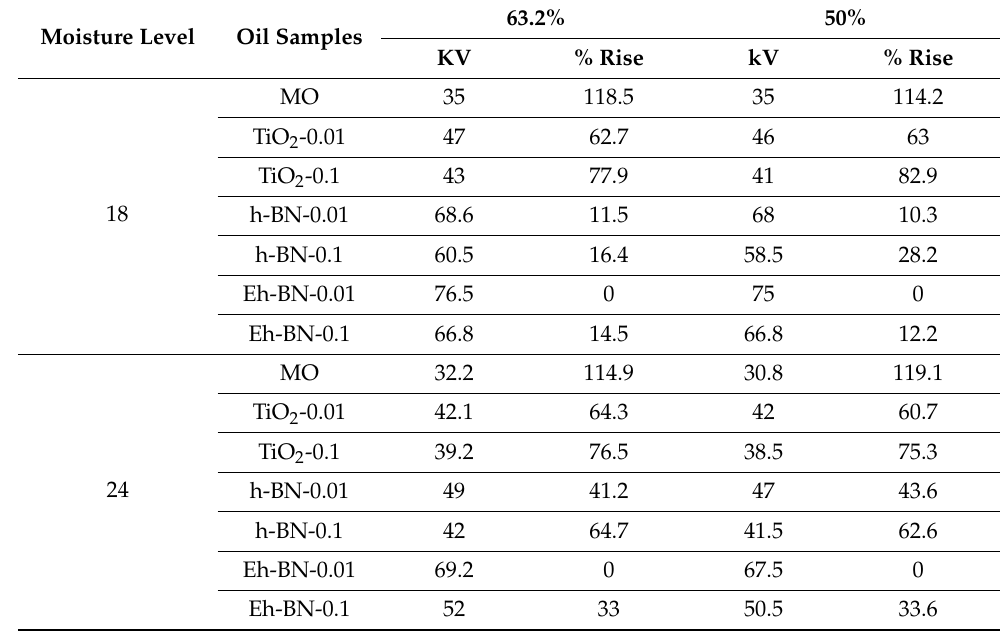
Table 6. Failure probabilities at 18 ppm and 24